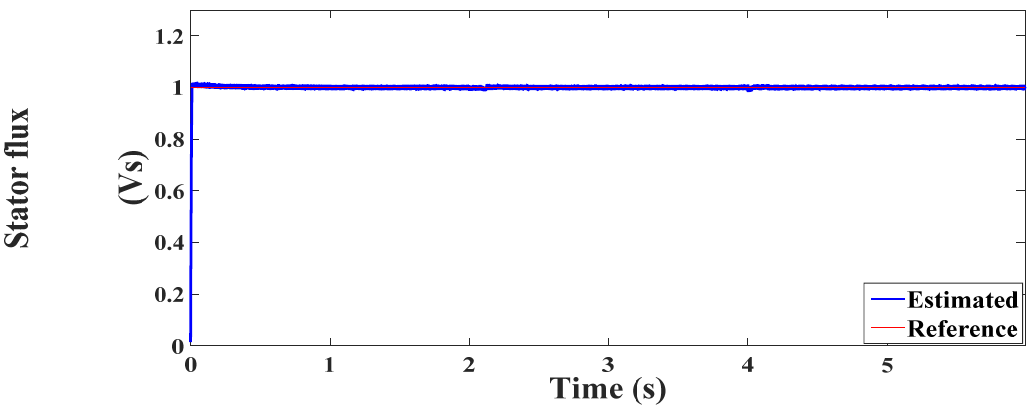
Figure 16. Stator flux profile under proposed PVC approach (Vs).